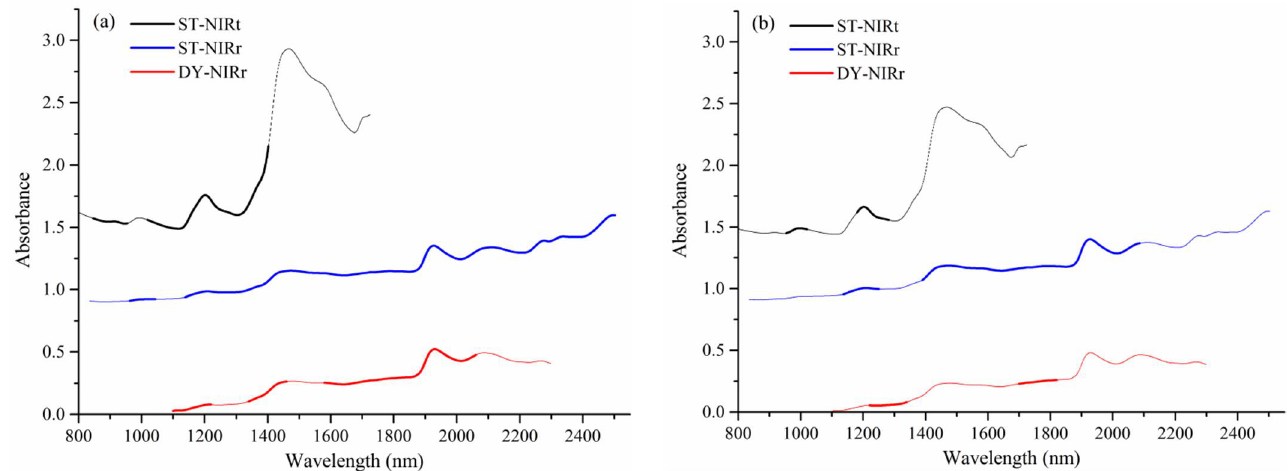
Figure 5. Characteristic bands used by the single rice kernel AC ( a ) and FC ( b ) NIRS models. (Note: In Figure 5a,b, the black, blue, and red dashed lines in the figure are the average spectra of single rice kernels under ST-NIRt, ST-NIRr, and DY-NIRr conditions, while the solid lines of corresponding colors represent the bands used in the ST-NIRt, ST-NIRr, and DY-NIRr models.). Figure 5a shows that the starch-related absorption peaks [19] near 1204 nm and 1464 Table 3. Comparison of different AC and FC detection methods by using rice kernels and rice flour nm are included in the ranges used in the three groups of single rice kernel AC models as the